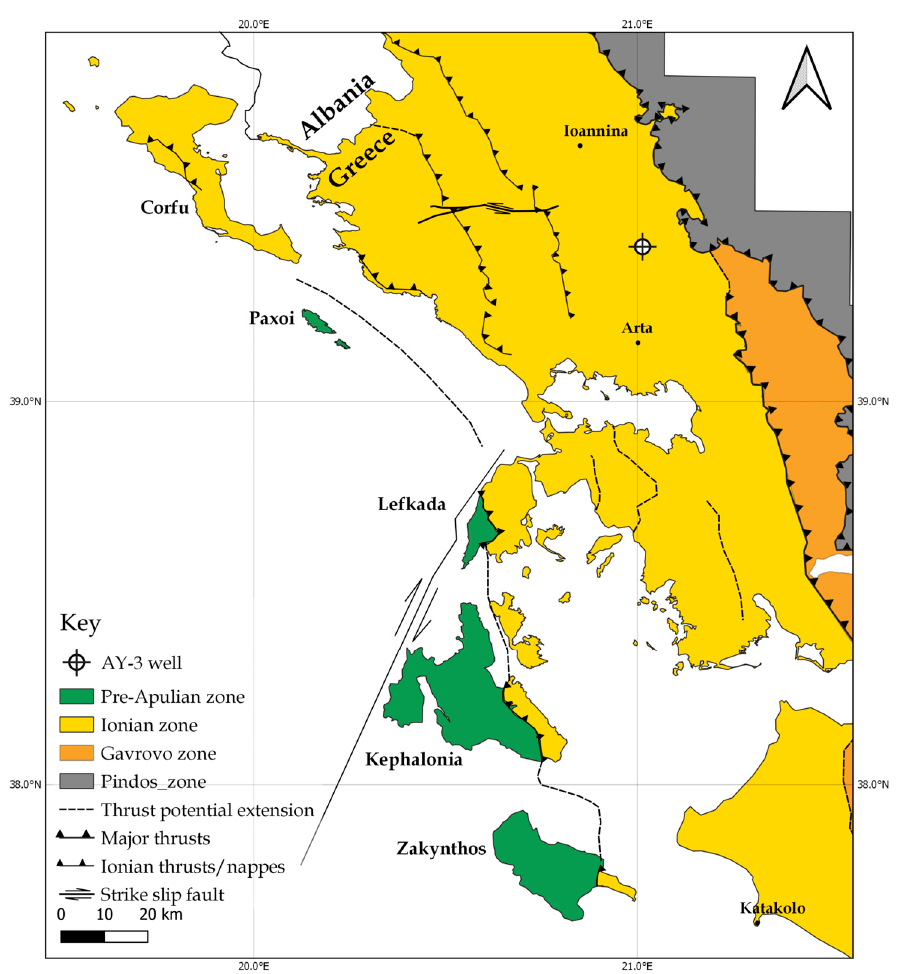
Figure 1. Simplified map of the geotectonic zones of the HFTB in Western Greece, illustrating the well under assessment (AY-3). Modified after [5,14,16,18].